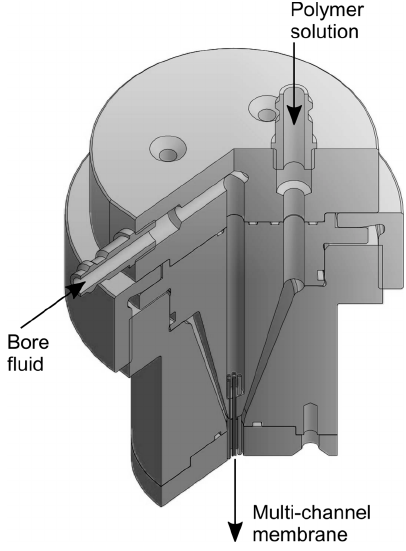
Figure 1. Sectional view of the multi-channel spinneret with seven bore fluid needles.